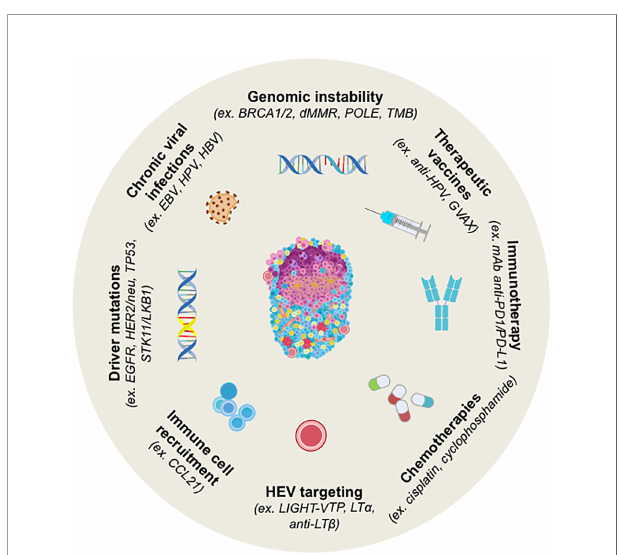
FIGURE 2 | Strategy for Induction of TLS neogenesis in human cancers and by cancer treatments. TLS are induced by chronic viral infections to which tumorigenesis has been associated with genomic instability and/or peculiar driver mutations in several tumors. Chemotherapy, immunotherapy or therapeutic vaccination can also induce TLS. In most cases, their presence is concomitant to better prognosis and higher clinical responses to treatments. Murine models have been explored for the induction of TLS by targeting HEV or the cells involved in organogenesis (i.e. CCL21). BRCA1/2, Breast cancer 1 and 2; dMMR, De fi cient Mismatch Repair; EBV, Epstein-Barr Virus; EGFR, Epidermal Growth Factor Receptor; GVAX, GM-CSF-secreting allogeneic PDAC vaccine; HPV, Human Papillomavirus; LIGHT-VTP, LIGHT (stands for homologous to lymphotoxin )-Vascular Targeting Peptide; LKB1, Liver kinase B1; LT a , lymphotoxin alpha; LT b , lymphotoxin beta; OSCC, Oral Squamous Cell Carcinoma; PDAC, pancreatic ductal adenocarcinoma; POLE, DNA Polymerase Epsilon, Catalytic Subunit; STK11, Serine Threonine Kinase 11; TMB, Tumor Mutational